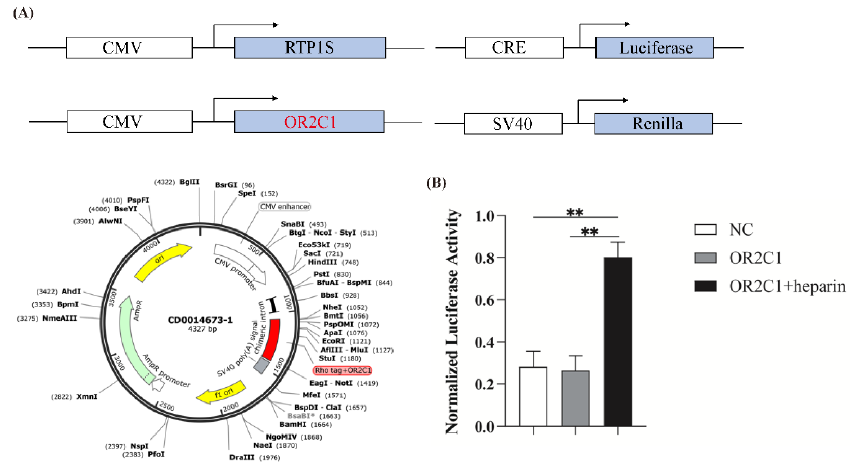
Figure 5. Construction of plasmid and Dual-Glo Luciferase Assay. ( A ) The structure of recombinant plasmid, including OR2C1, RTPIS, Luciferase, and Renilla; The genes of RTP1S and OR2C1 are driven by cytomegalovirus promoter (CMV), Luciferase (Luc) is driven by the cAMP response element promoter (CRE), and Renilla (RL) is driven by the constitutive promoter (SV40). ( B ) Dual-Glo Luciferase Assay. The formula ([(Luc/RL) N − (Luc/RL) lowest ]/[(Luc/RL) highest − (Luc/RL) lowest ]) was used to normalize the luciferase activity. ** p < 0.01. The data are representative of at least three independent experiments (mean ± SEM).